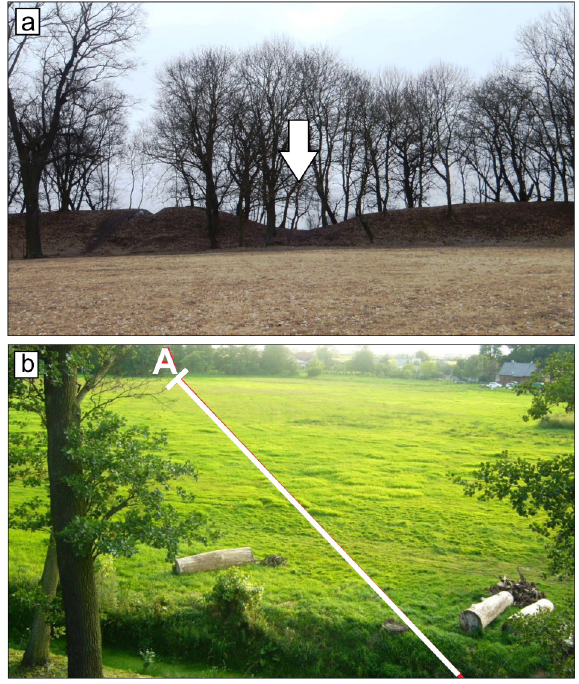
Fig. 4. view of the